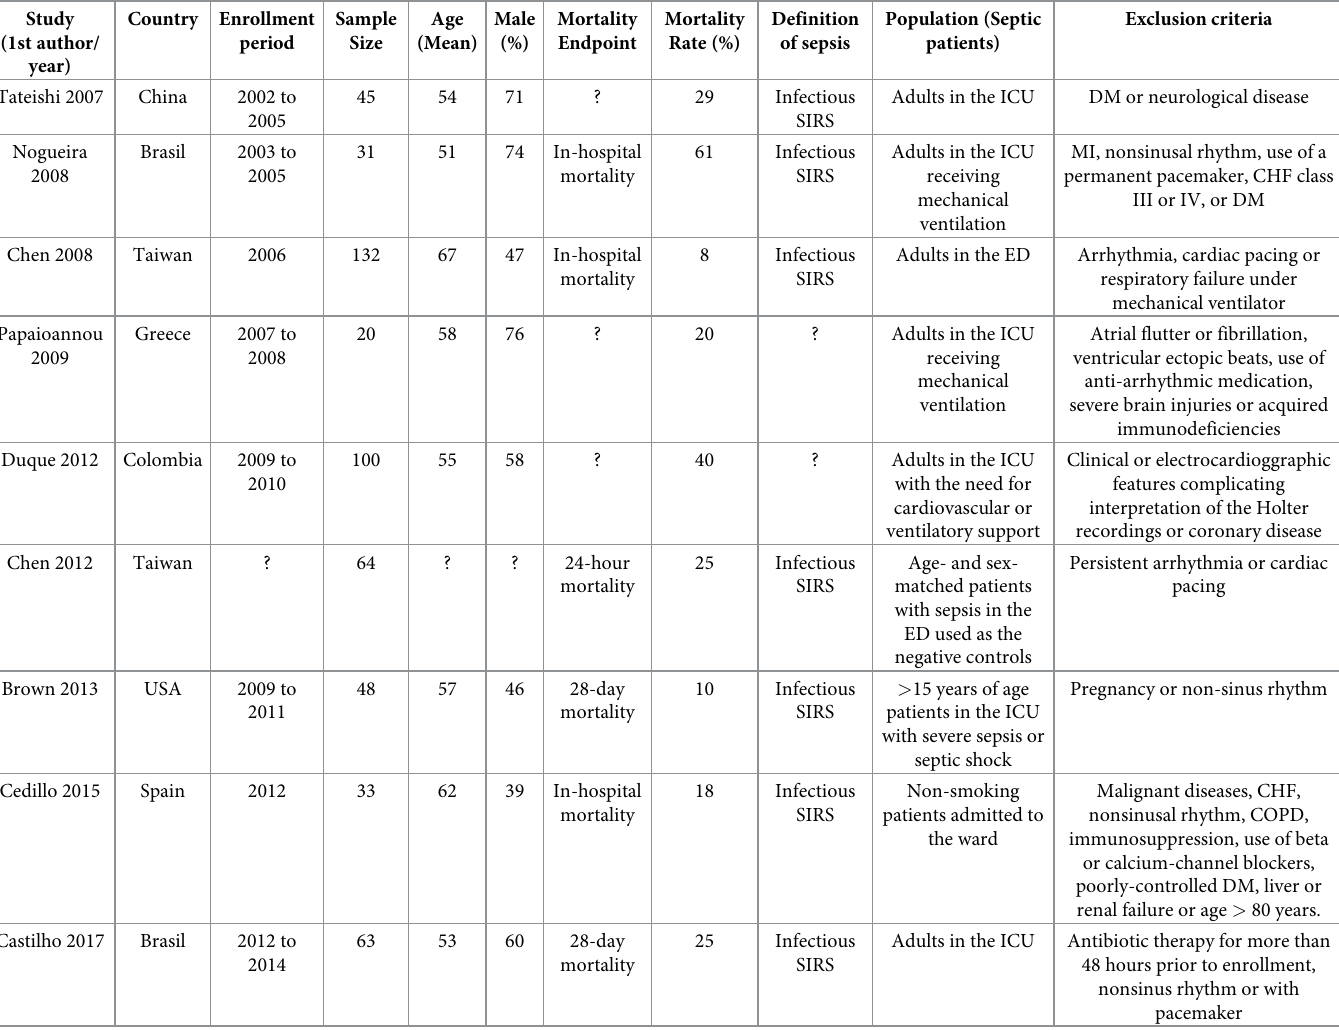
Table 1. Characteristics of included